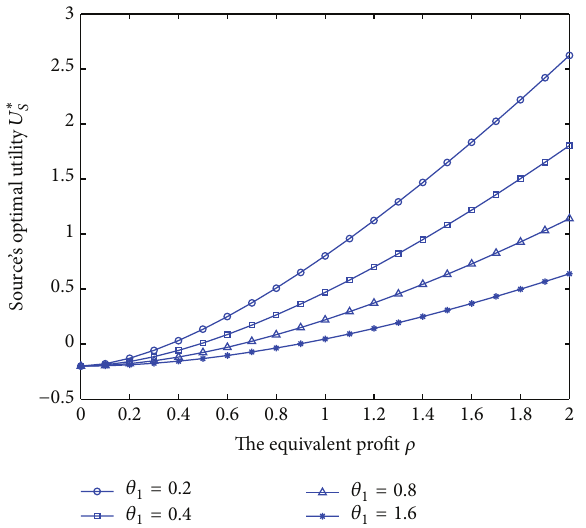
Figure 3: RNs’ optimal basic wage 𝛼 ∗ 1 versus the lowest RN type 𝜃 1 for fixed 𝑈 = 0.1 and 𝜌 = 1.5 .